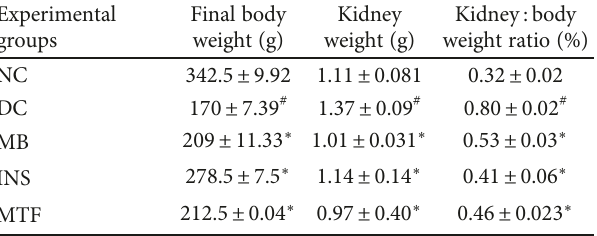
Table 3: E ff ects of M. balsamina on the kidney-to-body weight ratio after a 5-week study ( n = 6 in each group). Values are expressed as mean ± SEM